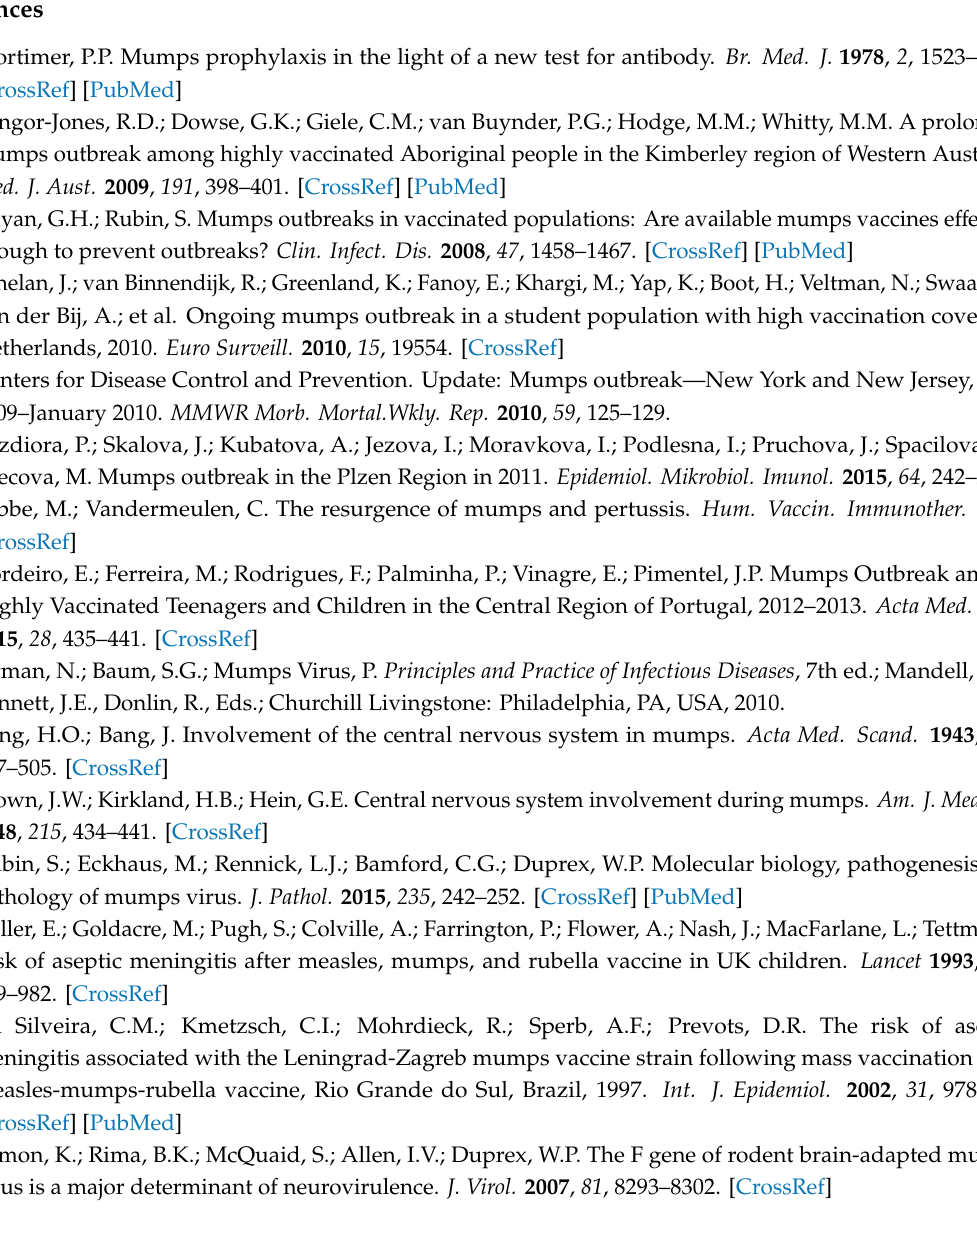
Figure S1: Degradation of STAT3 in FADU Cells. Confluent monolayers of FADU cells were infected with r88-1961 WT and r88-1961 E95D at an MOI of 1.0. Cell lysates prepared at the times indicated were subjected to SDS-PAGE and Western blot. The blots were probed with anti-STAT3, anti-B-actin, and anti-mumps P / V antibodies. Degradation of STAT3 was noticeably delayed in cells infected with r88-1961 E95D versus those infected with